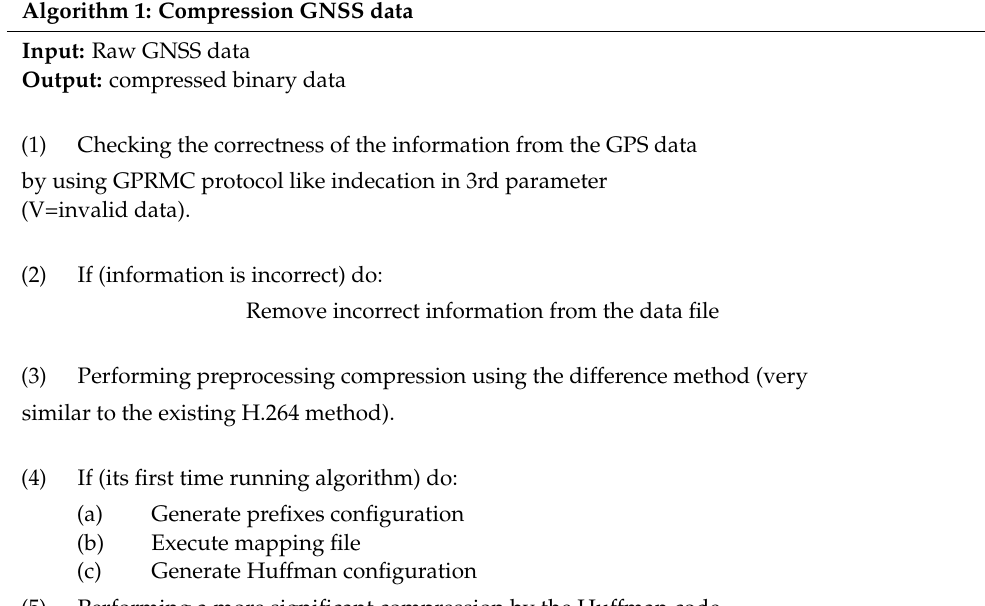
Algorithm 1: Compression GNSS data